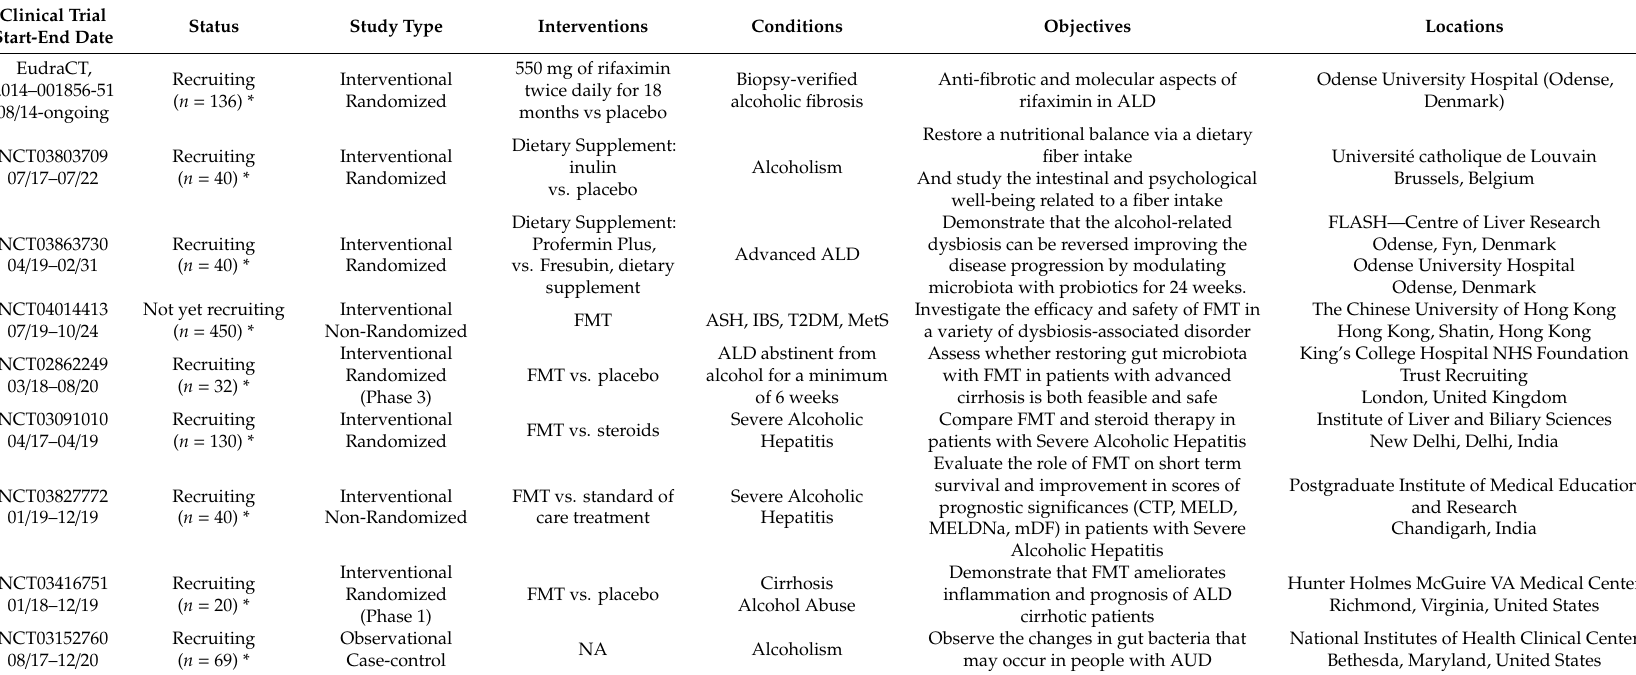
Table 1. Clinical trials currently underway addressing the therapeutic modulation of gut microbiota in ALD